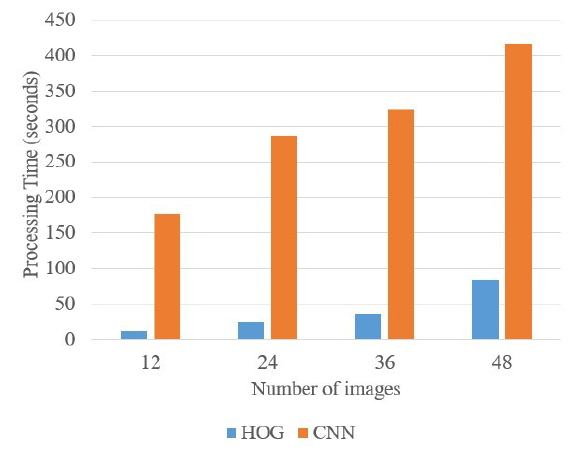
Figure 16. Display of the ‘creating a face dataset’ page.